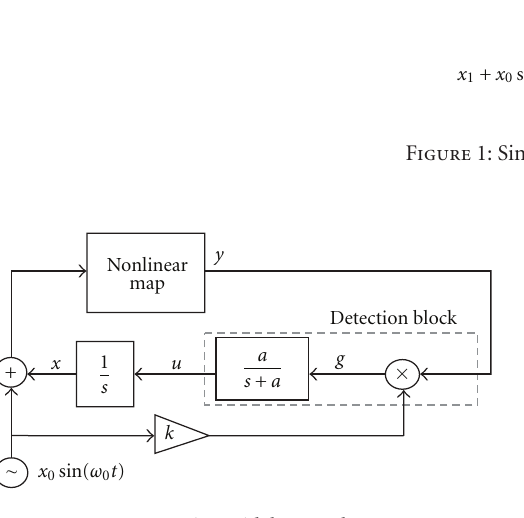
Figure 2: Sinusoidal ESC schema.